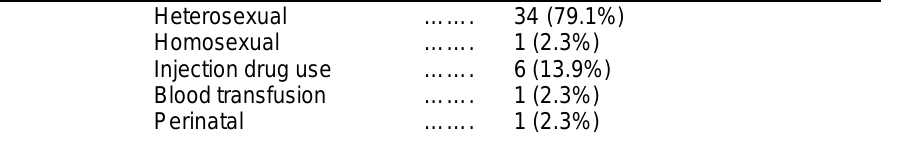
Table VI : Clinical presentation of HIV positive patients